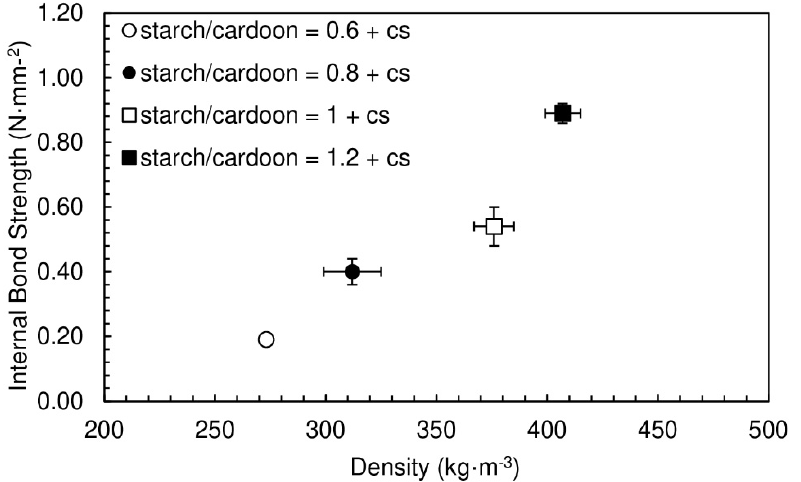
Figure 4. Internal bond strength of particleboards bonded with potato starch as function of density for starch / cardoon ratios of 0.6, 0.8, 1 and 1.2. All formulations had chitosan / starch ratio of 0.05 and water / starch ratio of 2.